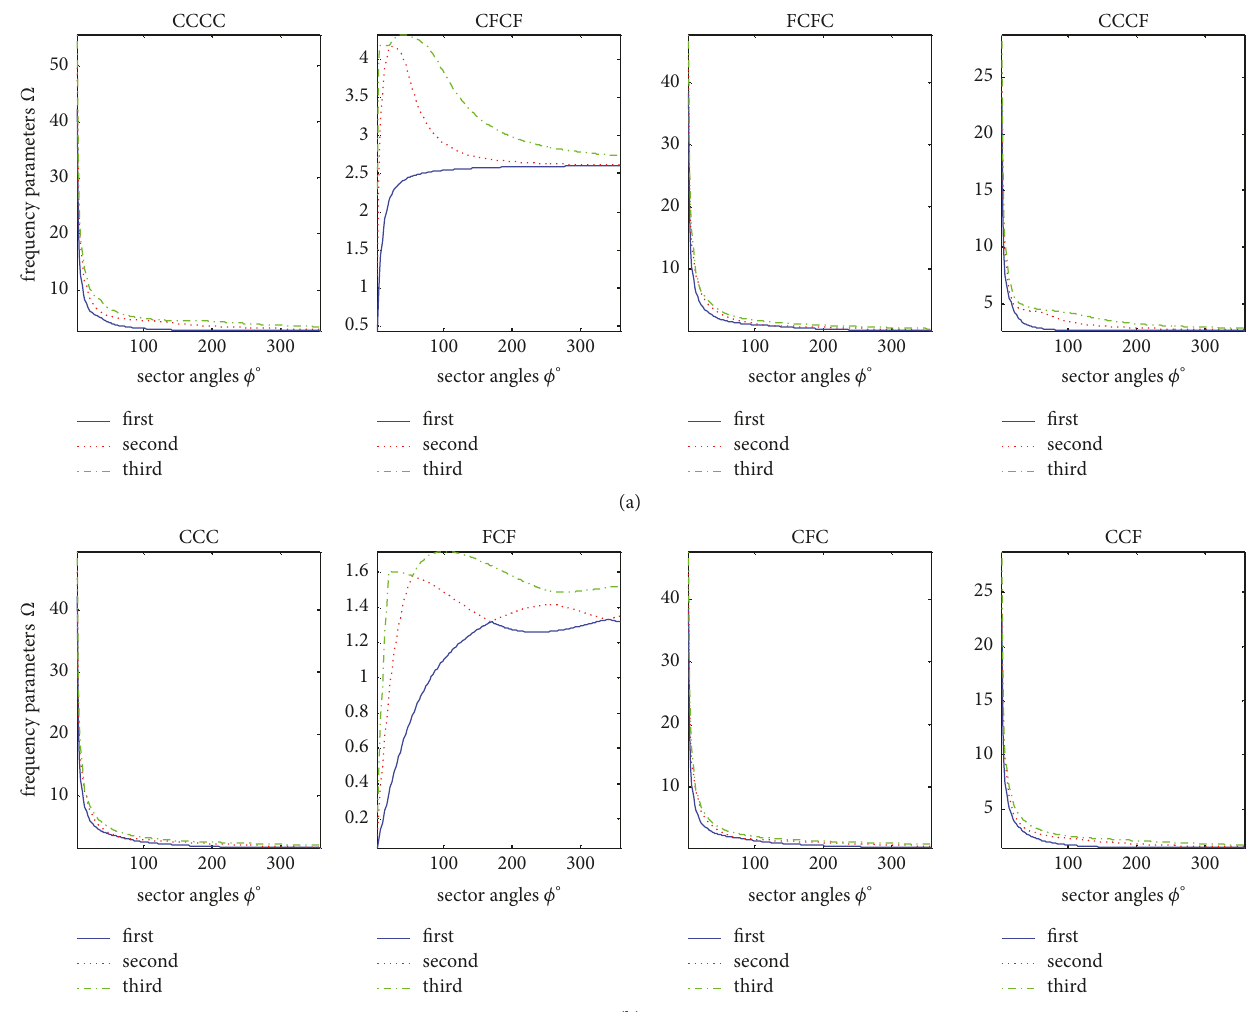
Figure 11: The variations of some frequency parameters for sector plates with different boundary conditions and sector angles: (a) annular sector plate; (b) circular sector